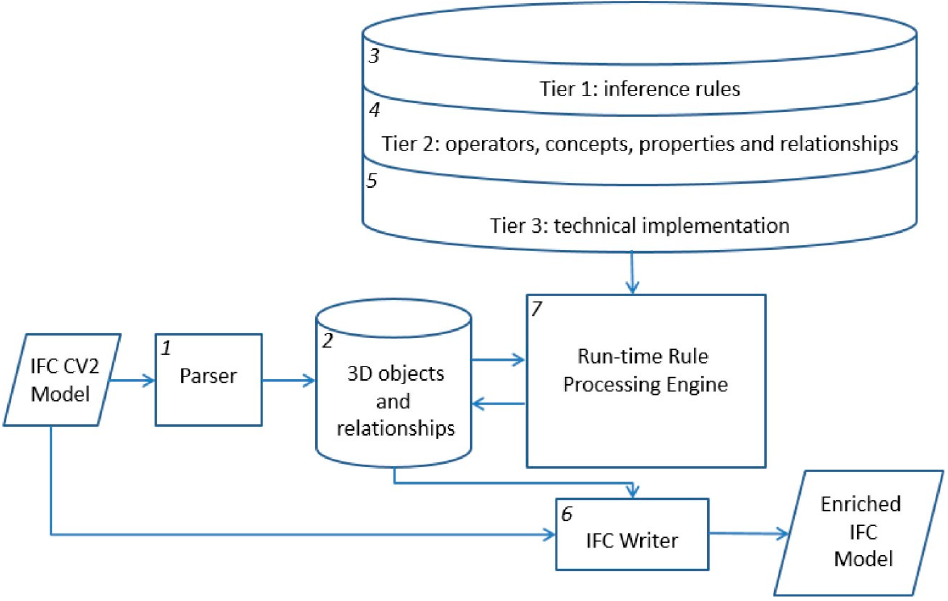
Figure 1. Semantic Enrichment Engine (SEE) architecture